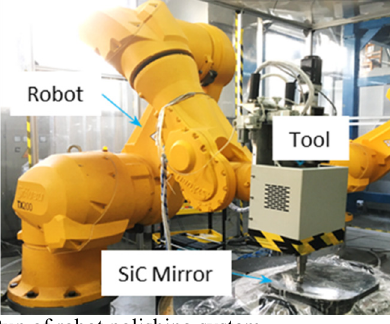
Fig. 1. Setup of robot polishing